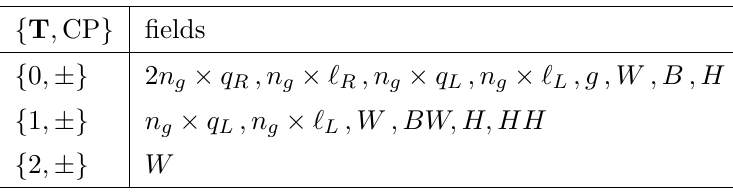
Table 2 . The 60 FFs required for the SM evolution can written in a basis with de(cid:12)nite conserved quantum numbers. 2(5 n g + 4) FFs contribute to the f 0 ; (cid:6)g states, 2(2 n g + 4) to each to the f 1 ; (cid:6)g and 2 to the f 2 ; (cid:6)g , where n g = 3 stands for the number of